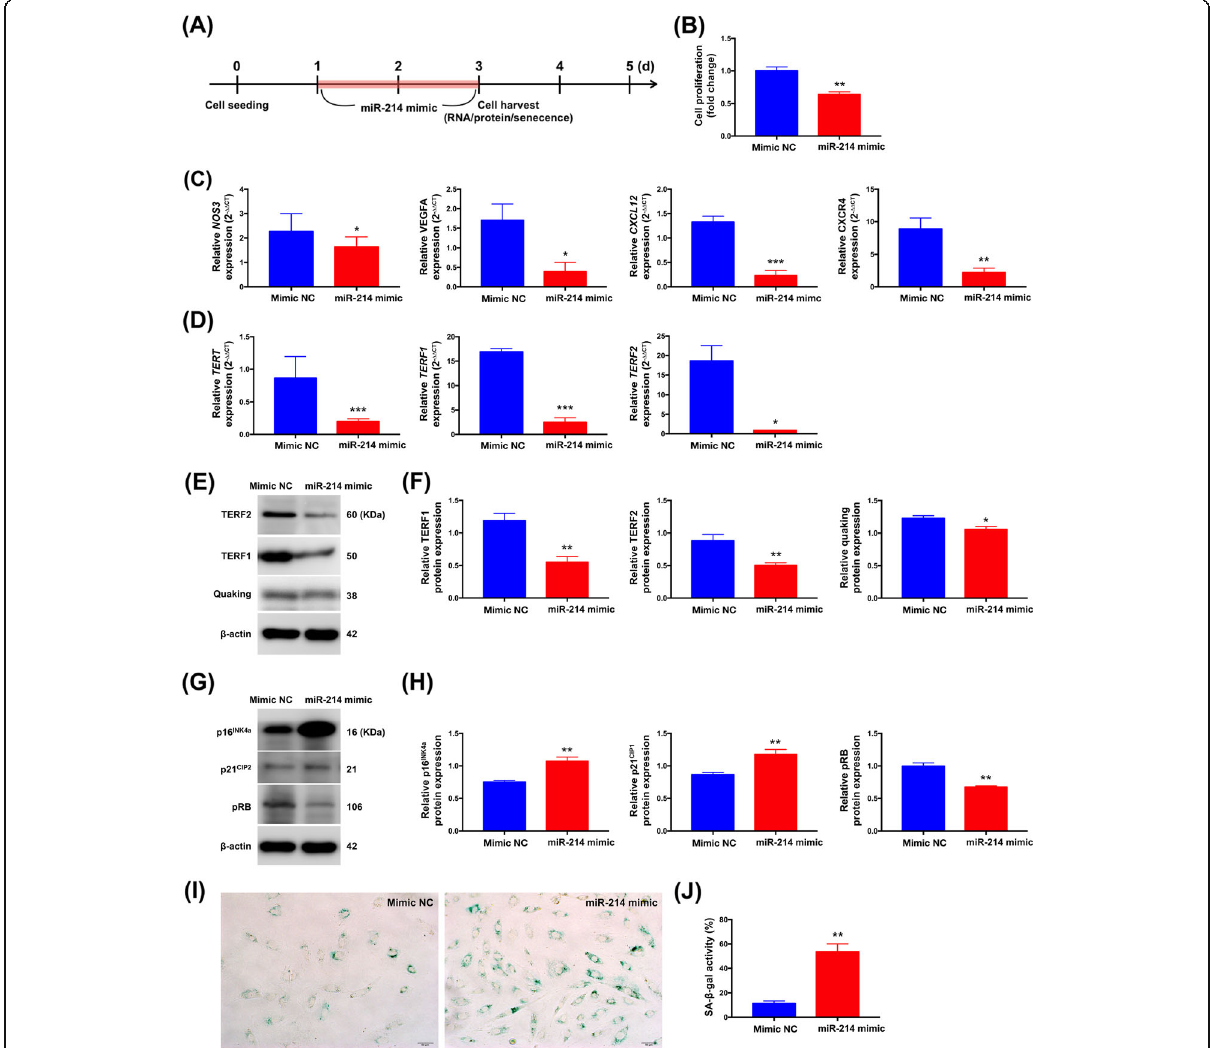
Fig. 4 MicroRNA-214-3p (miR-214) mimic in rat vascular smooth muscle cells (A7r5) suppressed angiogenesis and proliferation but promoted senescence. a Schematic of the protocol for transfection of A7r5 VSMCs with a miRNA mimic control (mimic NC) or a miR-214 mimic and processed at the indicated times. b The effects of miR-214 mimic on VSMC cell proliferation were tested by CCK-8 assay. c Angiogenetic mRNA expressions of NOS3, VEGFA, CXCL12 and CXCR4 compared in cells transfected with mimic NC or miR-214 mimic ( n = 3). d Senescence-associated mRNA expressions of TERT, TERF1 and TERF2 compared in cells transfected with mimic NC or miR-214 mimic ( n = 3). e , g Representative western blots depicting TERF1, TERF2, p16 INK4 , p21 CIP1 , pRB, and quaking expression in mimic NC or miR-214 mimic transfected cells. f , h Normalized expressions of TERF1, TERF2, p16 INK4 , p21 CIP1 , pRB, and quaking ( n = 3). i Senescence-associated β -galactosidase staining demonstrating senescence in mimic NC or miR-214 mimic transfected cells. j Bar graphs show quantification of relative of SA- β -gal positive cells ( n = 3). Data are presented as the means± SEM. * P < 0.05; ** P < 0.01; *** P < 0.001 (Two-tailed Student ’ s